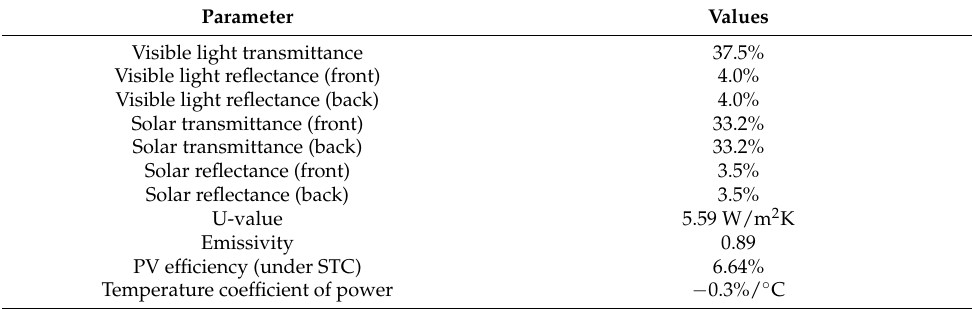
Table 6. Thermal and optical properties—semi-transparent perovskite PV